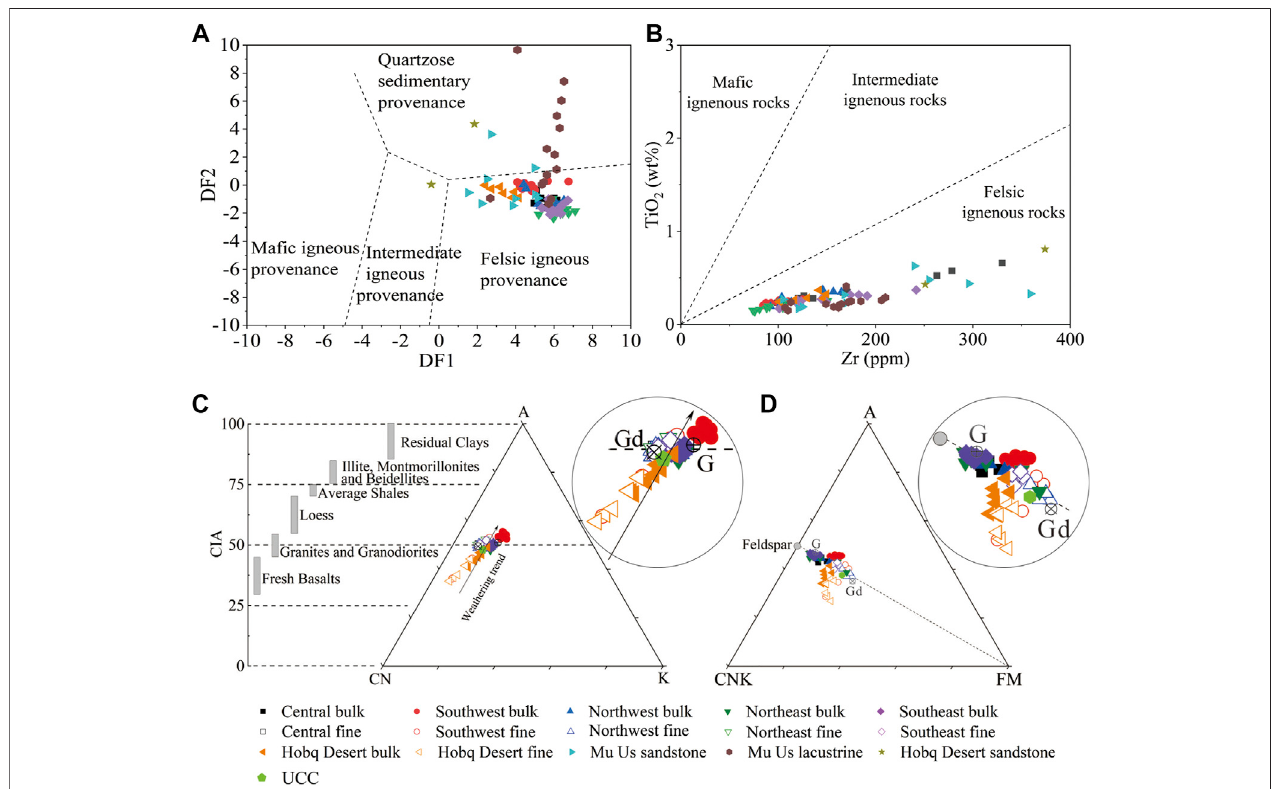
FIGURE 11 | Diagrams characterizing primitive source rock nature for the sediments in the Ordos Deserts. (A) DF1 vs. DF2. (B) Zr vs. TiO 2 plot. The triangular diagram of A-CN-K (C) and A-CNK-FM (D) for sediments in the Ordos Deserts. Gd and G represent granitoid and granite, respectively. The CIA values of fresh basalts, granitoid and granite, loess, average shales, illites, montmorillonites, beidellites, and residual clays are from Taylor and McLennan (1985) and Nesbitt and Young (1982). Data of sandstone and lacustrine sediments in Mu Us and the Hobq Desert is from Liu and Yang (2018).